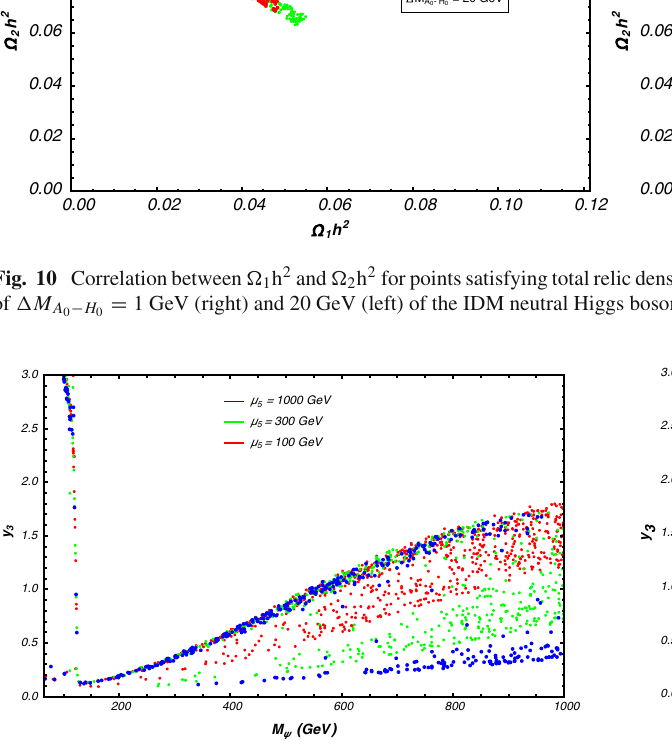
Fig. 11 Regions of y 3 − M ψ plane compatible with the relic density bound for specific choices of μ 5 values, indicating the strong presence of the conversion channel ψψ → H 0 H 0 in the resonant region with = 2 M ψ M H S